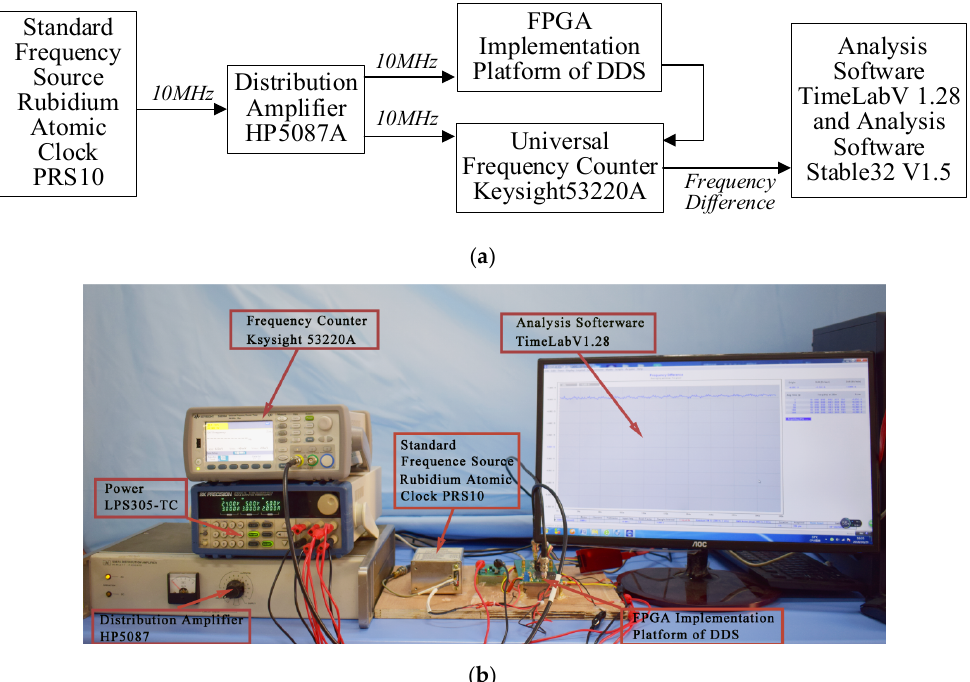
Figure 8. Experimental platform for testing the characteristics of the DDS. ( a ) Block diagram of the experimental platform; ( b ) Photograph of the experimental platform.